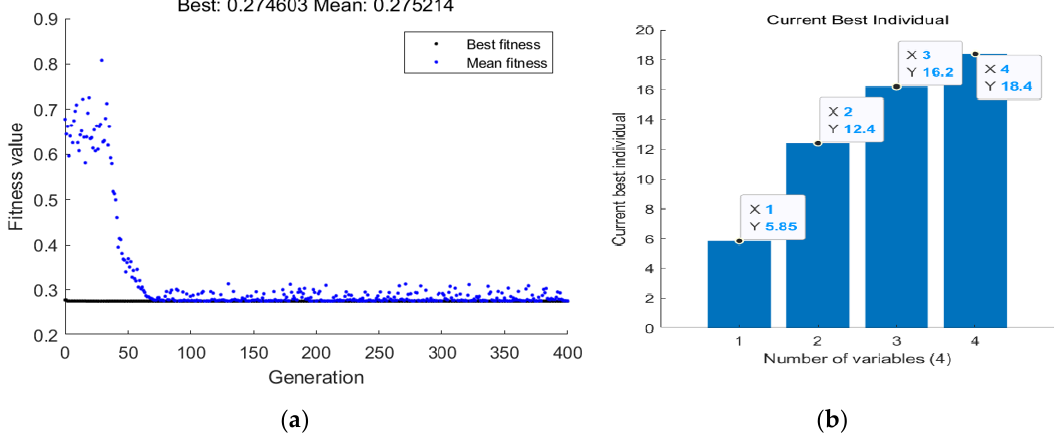
Figure 13. Results of genetic algorithm: ( a ) fitness value; ( b ) current best individual.